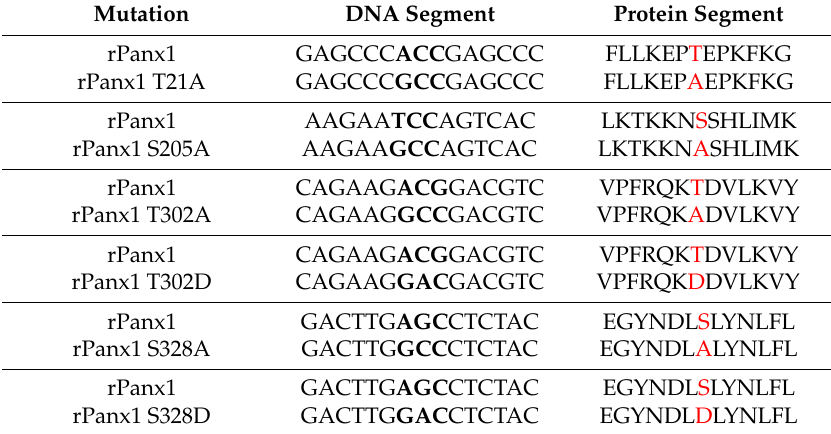
Table 1. Sequences of alanine and aspartate mutations of putative phosphorylation sites of Panx1 by PKA.